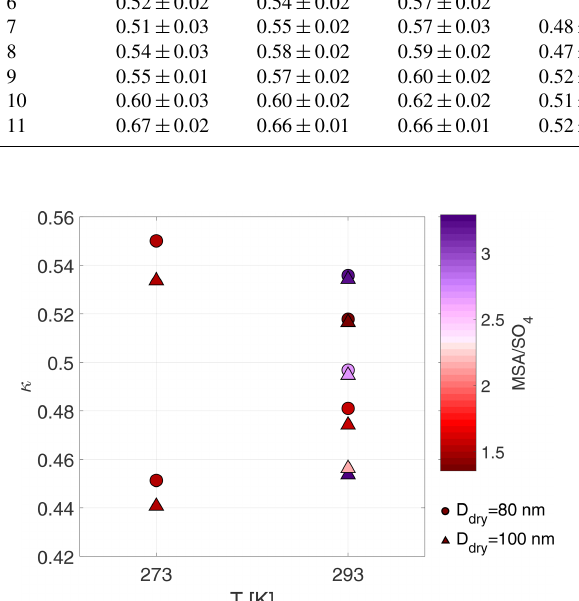
Figure 5. Mean κ values at 273 and 293K for particles with dry sizes of 80 and 100nm. Colour scheme shows the average MSA to sulfate ratio during the time period when the specific dry size was measured. Exp. 1–9 are